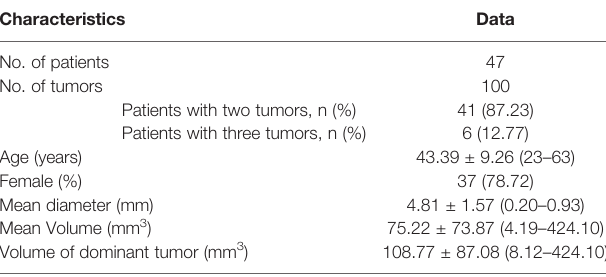
had three tumors. The mean diameter was 4.82 ± 1.57 mm and the mean volume was 75.22 ± 73.87 mm 3 . The volume of dominant tumor was 108.77 ± 87.08 mm 3 . TABLE 1 | Clinical characteristics of patients.